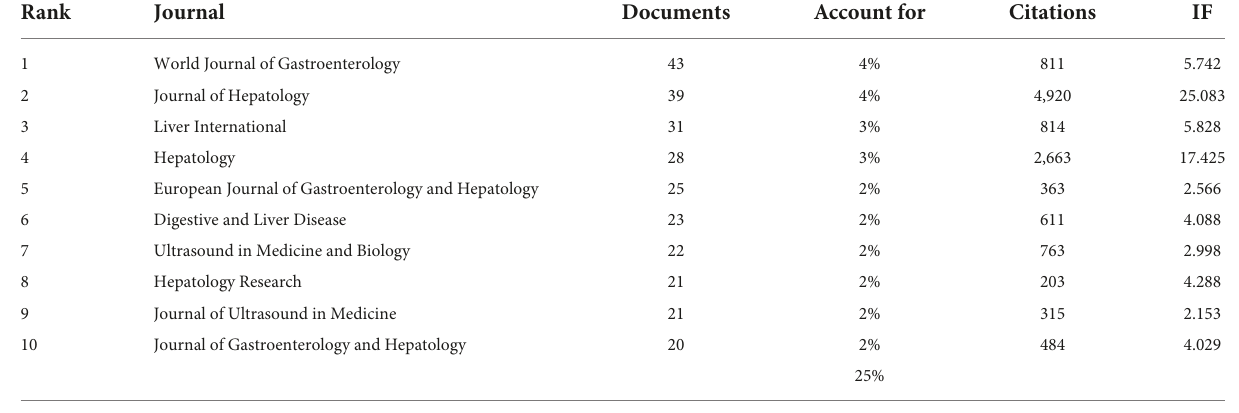
TABLE 1 Top 10 high-yielding journals.